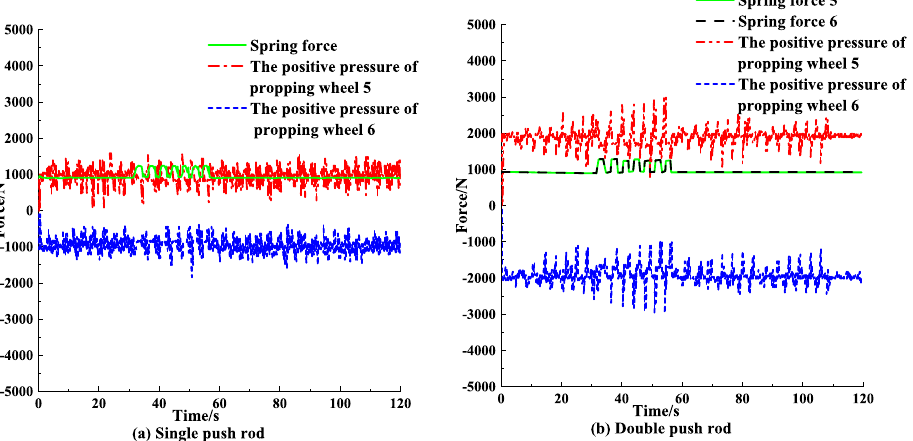
Figure 13. The change of positive pressure of single push rod support adjustment mechanism, double push rod − double spring support adjustment mechanism under the barrier of casing